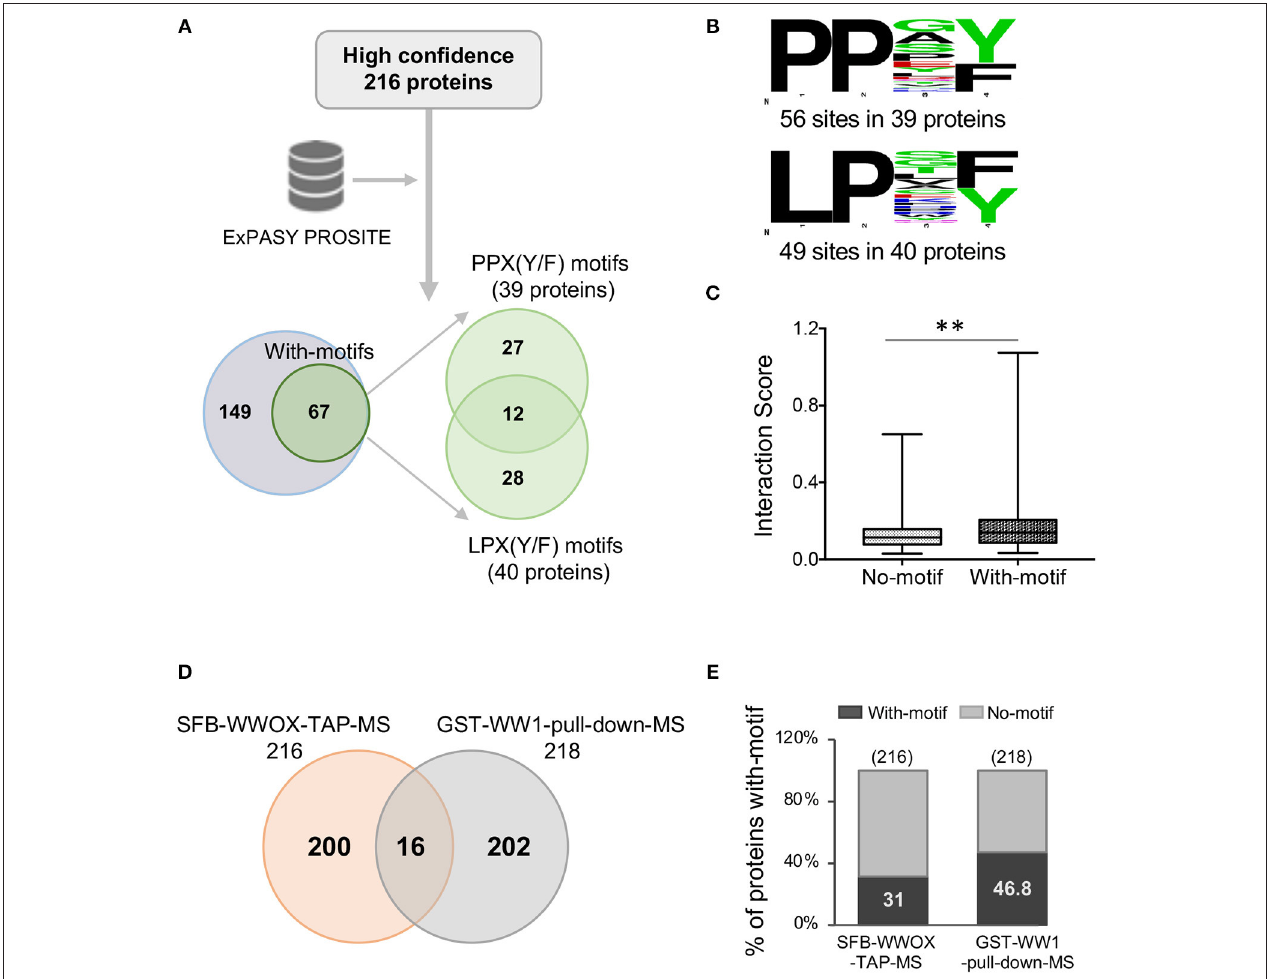
FIGURE 4 | WW domain binding motifs in WWOX interacting proteins. (A) ExPASY PROSITE analysis was performed on the list of 216 WWOX interactors ( Supplementary File 2 ). Candidate WWOX WW1 domain binding motifs were identified in 31% (67 out of 216) proteins. Out of 67 proteins with putative WW1 binding motifs, 12 candidate WWOX binding interactors displayed both PPX(Y/F) and LPX(Y/F) motifs. (B) Amino acid sequence of candidate WWOX WW1 domain binding motifs. The probability of the residue at each position is proportional to the size of the letters. The image was generated using the Weblogo 3.4 program. Thirty-nine proteins displayed PPX(Y/F) motifs at 56 sites and 40 proteins displayed LPX(Y/F) motif at 49 sites. (C) Box and whisker plot showing the comparison of median interaction scores between proteins with- and without-motifs. Proteins with-motifs display higher interaction scores (mean interaction score = 0.1875) vs. proteins with No-motifs (mean interaction score = 0.1287). Statistical analysis was done using two-tailed unpaired Student’s t -test, ** p < 0.001. (D) Comparison of SFB-WWOX-TAP-MS data with GST-WW1-pull-down-MS data from Abu-Odeh (34). Only 16 common WWOX interactors were identified overlapping both datasets. (E) Bar graph showing a comparison of the percentage of proteins with WWOX binding motifs between the aforementioned datasets. Thirty-one percent of proteins from the SFB-WWOX-TAP-MS dataset (this study) displayed candidate WW1 binding motifs vs. 46.8% of proteins in the GST-WW1-pull-down-MS dataset